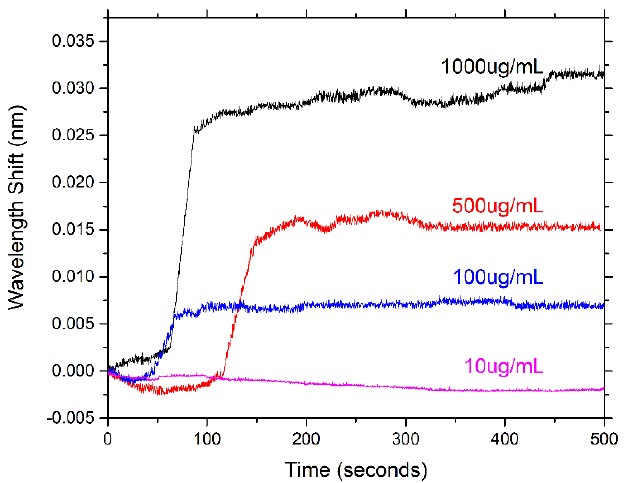
Figure 15. Representative response of one of the PEG-biotin:PEG coated microresonators for different concentrations of avidin. The wavelength shift declines as the concentration of avidin declines. Minimal response is seen at the concentration of 10 μ